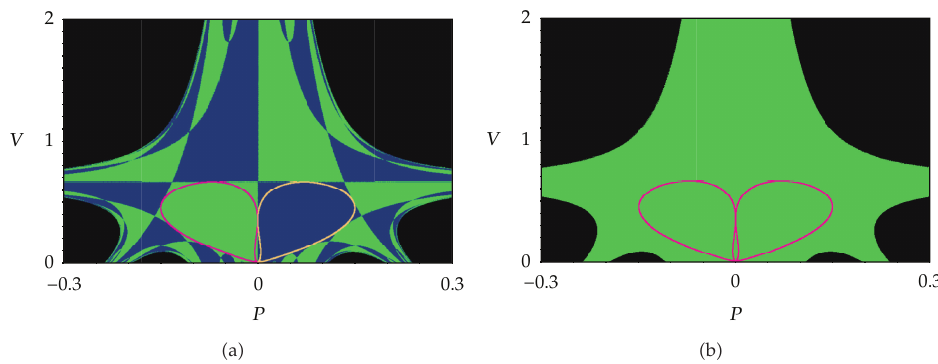
Figure 3: Phase diagrams illustrating symmetric homoclinic bifurcation. Diagram on right (cid:3) N (cid:8) 3 . 010 (cid:4) includes the period-2 attractor basins for the two limit cycles prior to the bifurcation. Diagram at left (cid:3) N (cid:8) 3 . 011 (cid:4) shows the attractor formed from the merging limit cycles and resulting loss of local attractor basin